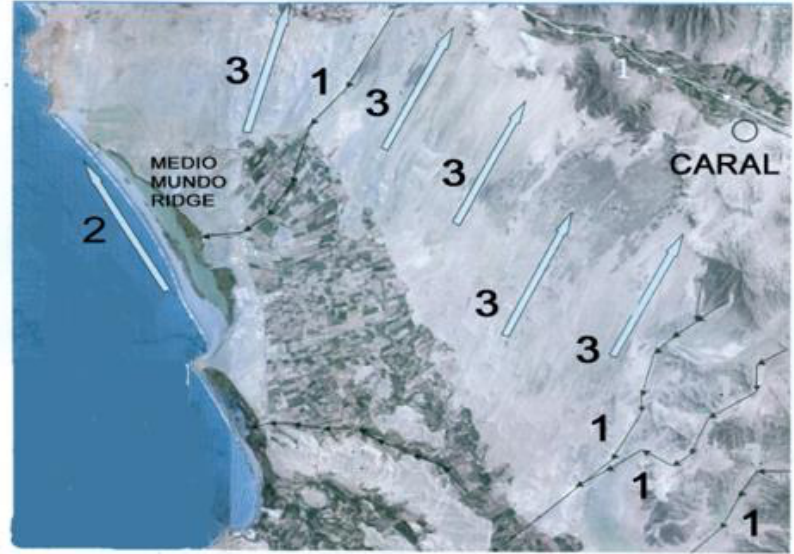
Figure 34. Major environmental changes resulting from the Medio Mundo beach ridge. Derived figure from Google Earth.